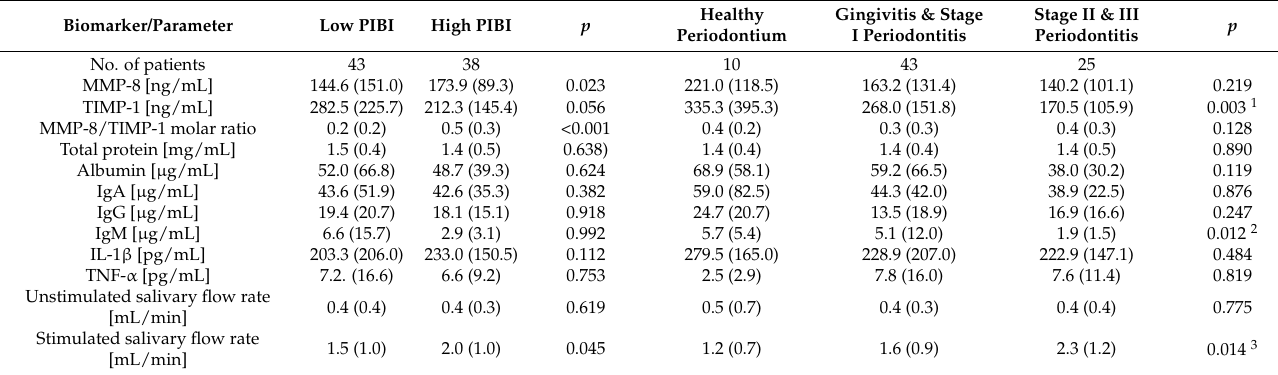
Table 3. Salivary biomarkers and salivary flow rates in liver transplant recipients with good and impaired periodontal health and with and without periodontal